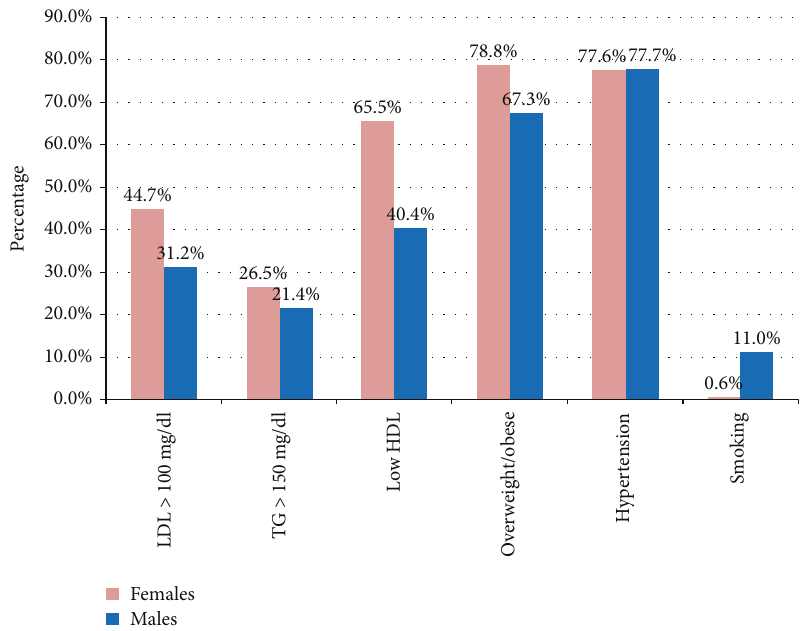
Figure 1: Prevalence of cardiovascular risk factors in the study population by gender (females n = 2180 , males n = 820 ).